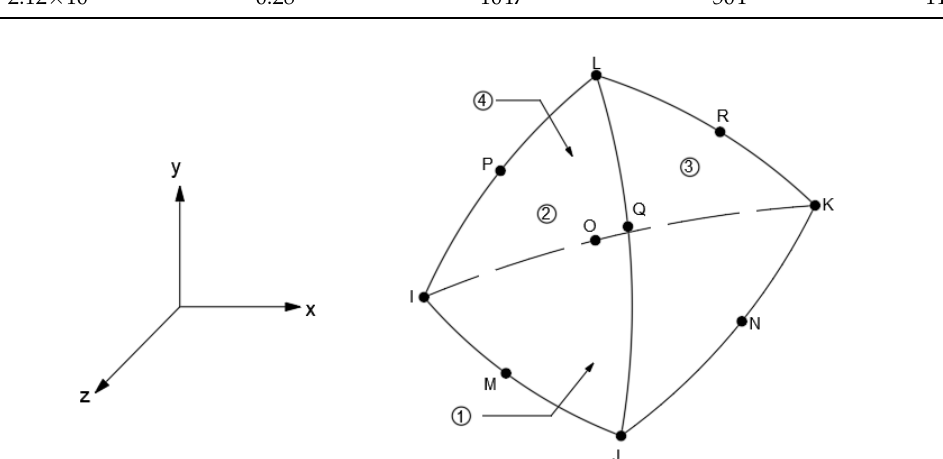
Figure 14. SOLID187 unit figure. Table 2. Performance indicators of 42CrMo.